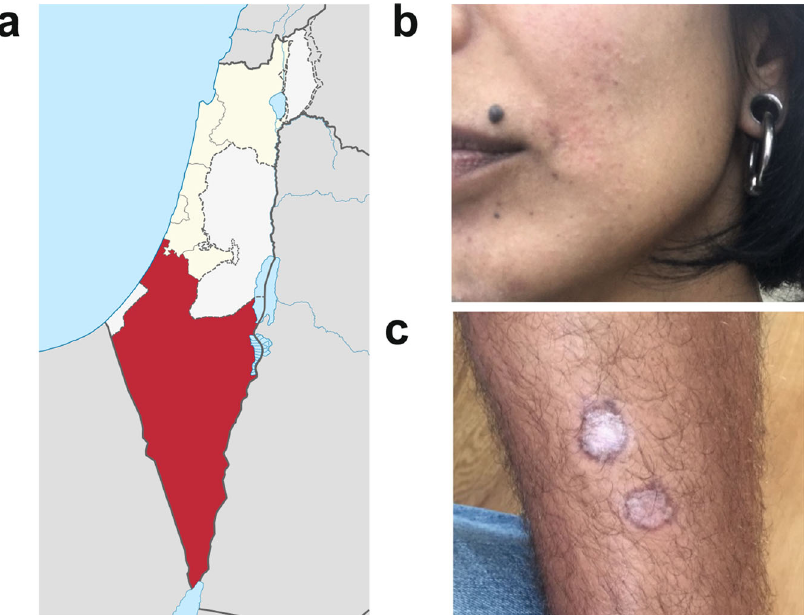
Fig. 1 Clinical characteristic of patient lesions. a Negev region of Israel (red). Source: Israel location map.svg NordNordWestderivative work: CC BY-SA 3.0 https://creativecommons.org/licenses/by-sa/3.0, via Wikimedia Commons. b Donor MRC-01 lesion photographed ~3 months after treatment onset, showing full resolution of the lesion near the corner of the mouth, with minimal scarring. c Donor MRC-02 lesions photographed ~9 months after travel to the endemic region, showing healing without